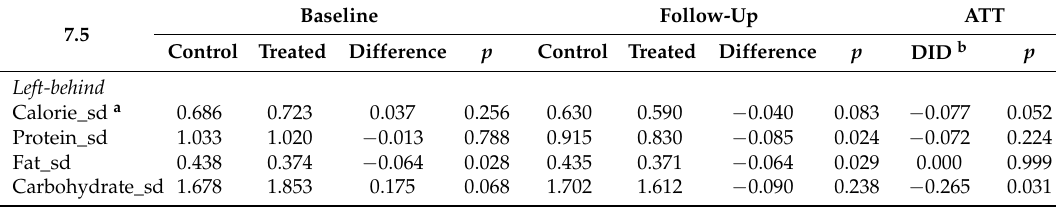
Table 4. Average treatment effect of treated (ATT) on nutrition caused by parents’ migration.